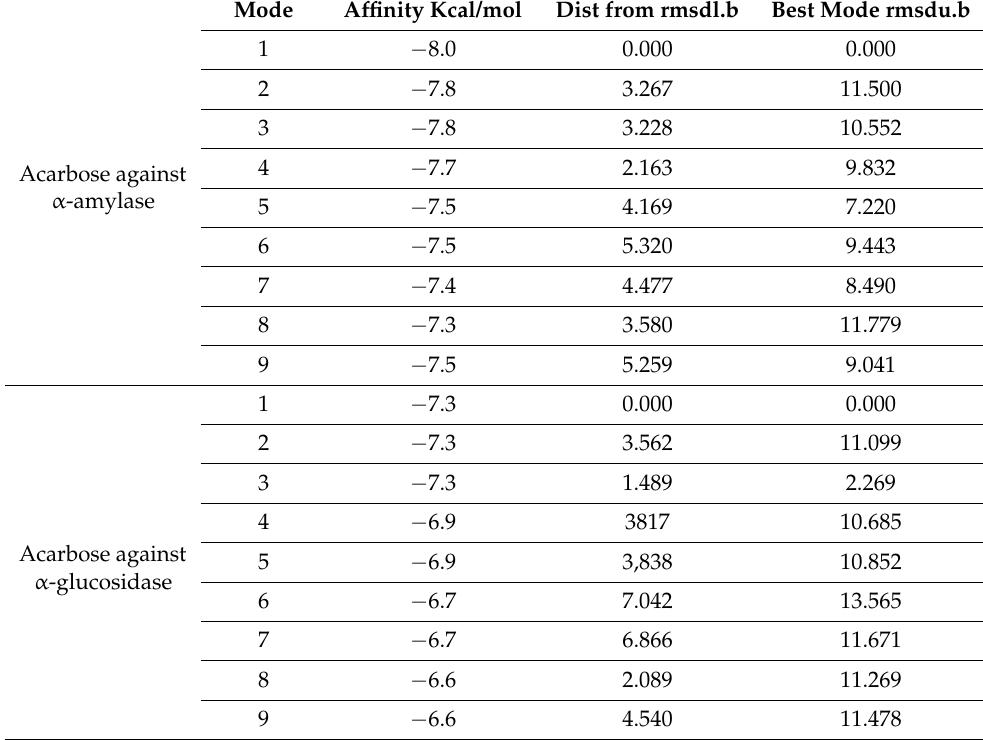
Table 5. The binding affinity and RMSD value of acarbose against α -amylase and α